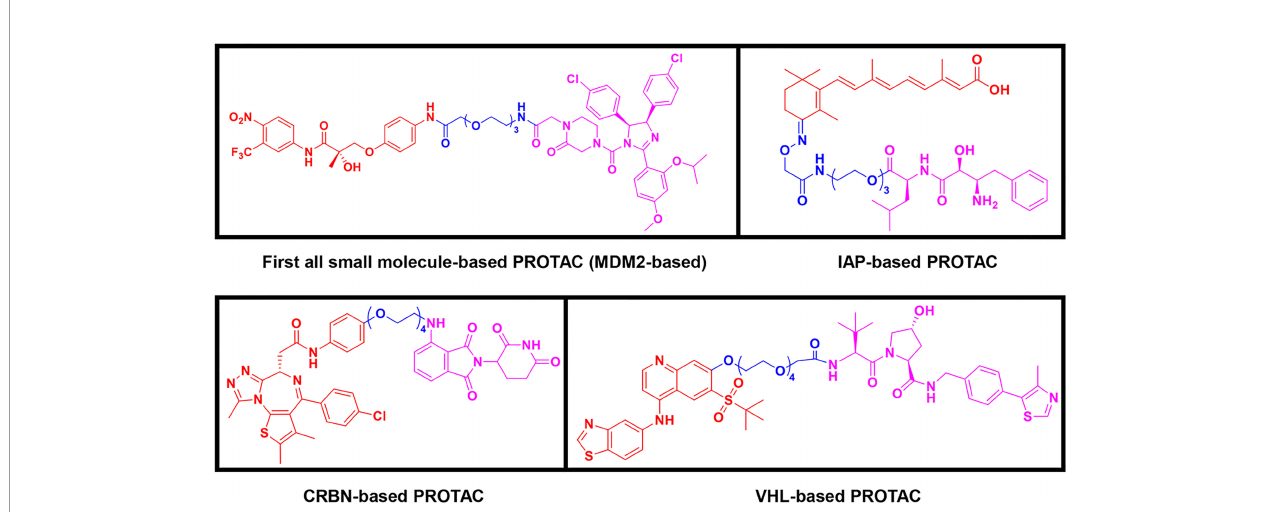
FIGURE 3 | Second-generation PROTACs, Small molecule-based PROTACs. Chemical structures of fi rst all small molecule-based PROTAC (MDM2-based), representative IAP-based PROTAC, representative CRBN-based PROTAC, and representative VHL-based